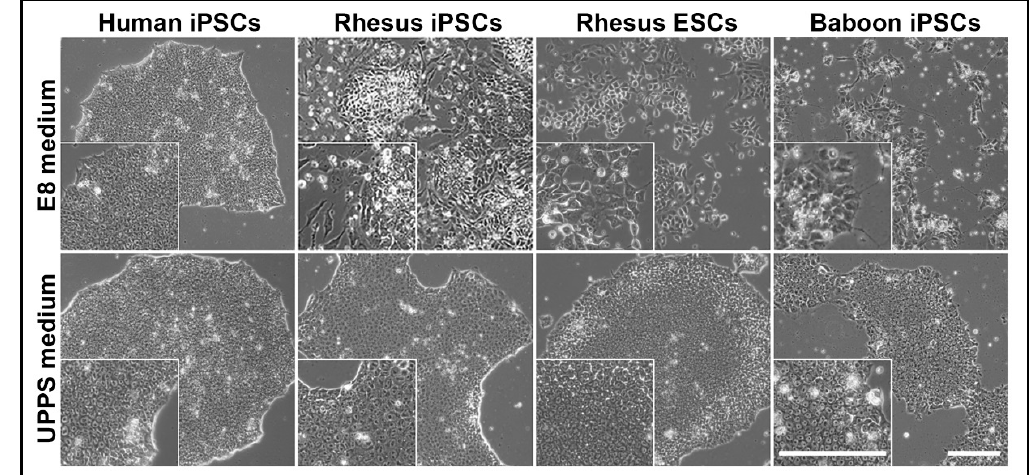
Figure 4. Morphology of human, rhesus, and baboon PSCs cultured feeder-free in Essential 8 (E8) medium and Universal Primate Pluripotent Stem Cell (UPPS) medium. Human iPSCs grow as compact colonies showing the typical primed PSC morphology when cultivated in both, E8 and UPPS medium. In contrast, baboon and rhesus iPSCs differentiate spontaneously when cultured in E8 medium but maintain undifferentiated compact colonies in UPPS medium. Adaptation of rhesus ESCs (line R344.6) from feeder-dependent to feeder-free condition failed in E8 medium. Cultured in UPPS medium, rhesus ESCs form compact undifferentiated colonies. Scale bars: 200 μ m.